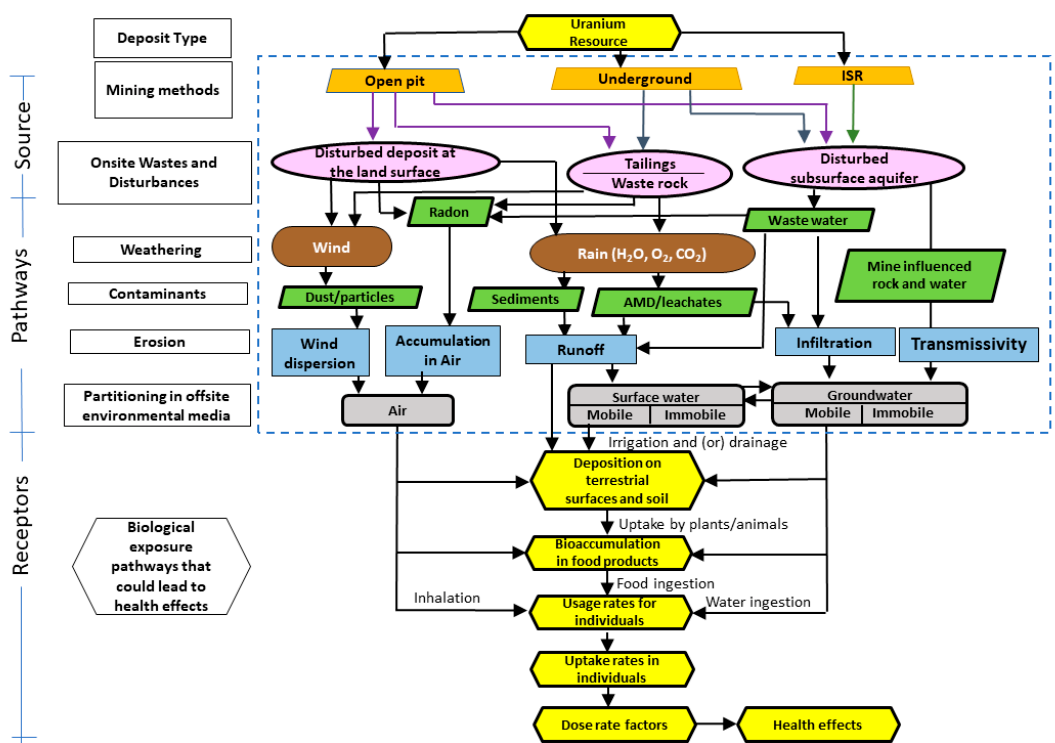
Figure 2. Source-to-receptor model for the geoenvironmental assessment modified after Gallegos et al. [3]. In situ recovery (ISR) is the method that has been used to extract uranium from the Goliad Sand.